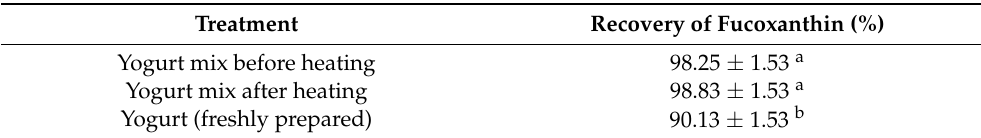
Table 2. Percent recovery of fucoxanthin in yogurt mix before heating, after heating, and in the freshly